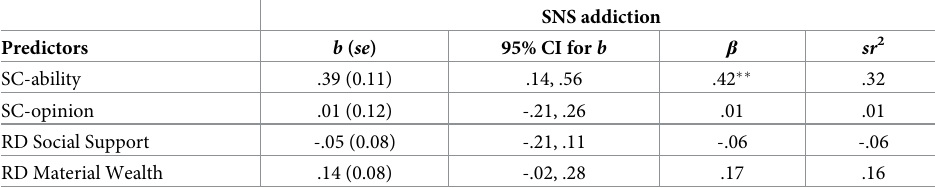
Table 2. Multiple regression analysis in Study